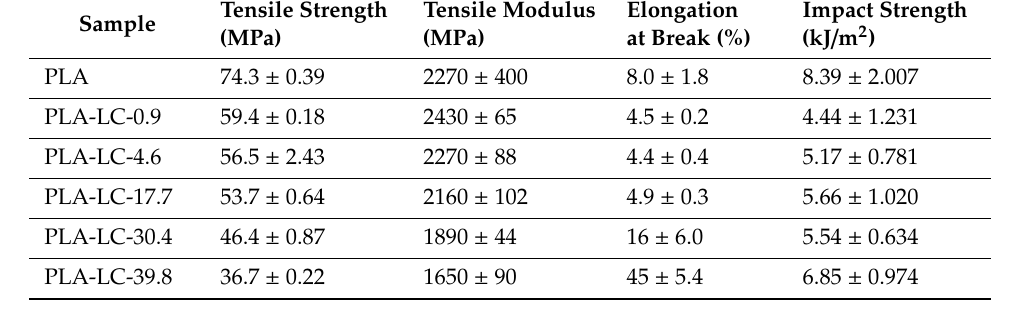
Table 4. Mechanical properties of PLA-LC composites.